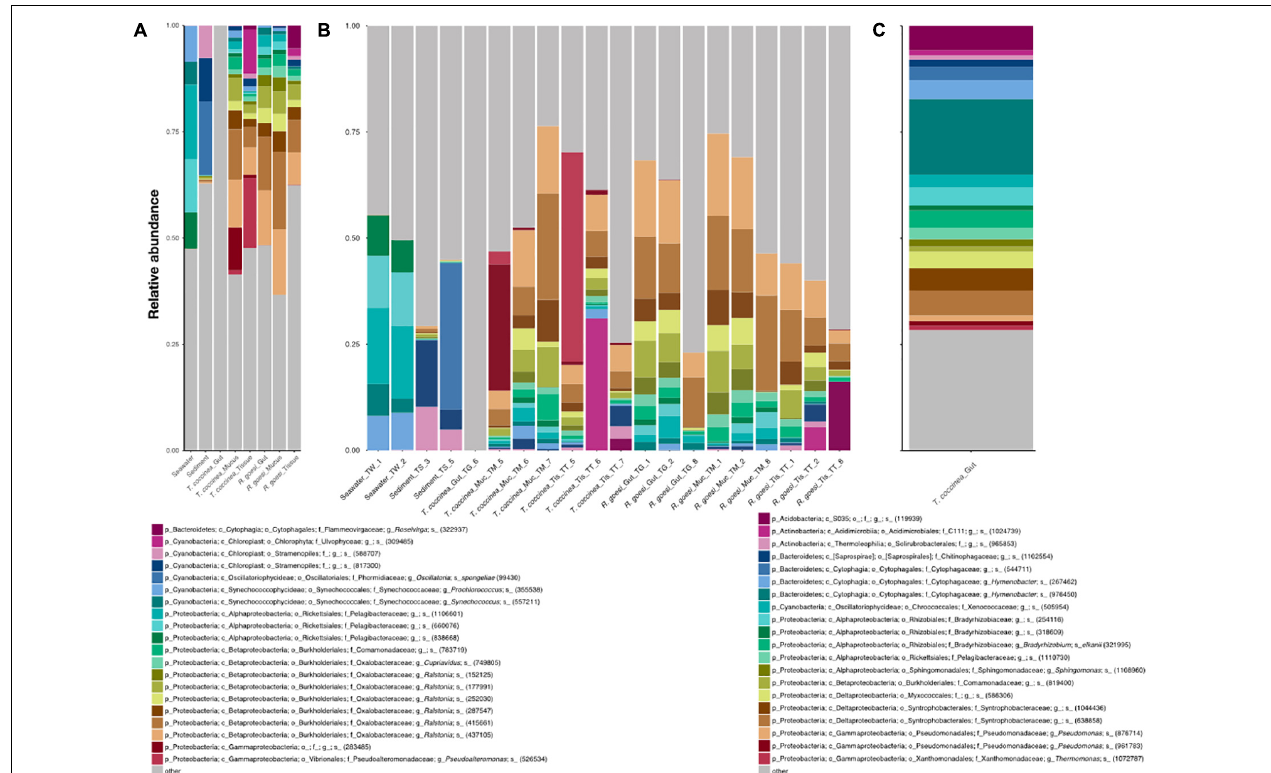
FIGURE 2 | Microbial community composition (relative abundance) resolved for (A) the seawater, sediment, and the cup corals R. goesi and T. coccinea across their surface mucus layer, tissue, and gastrovascular cavity (or “gut”), based on partial 16S rRNA amplicon sequencing. Only the 20 most abundant operational taxonomic units (OTUs) are depicted and the remainder pooled into “others”; (B) shows the same results but for each individual sample; (C) shows the particular community composition for the gastrovascular cavity of T. coccinea , which did not share any of the 20 most abundant OTUs with the other sampling groups. Affiliation of each OTU shows its lowest identified taxonomic rank: (p) phylum, (c) class, (o) order, (f) family, (g) genus, and s (species), plus an OTU code (within